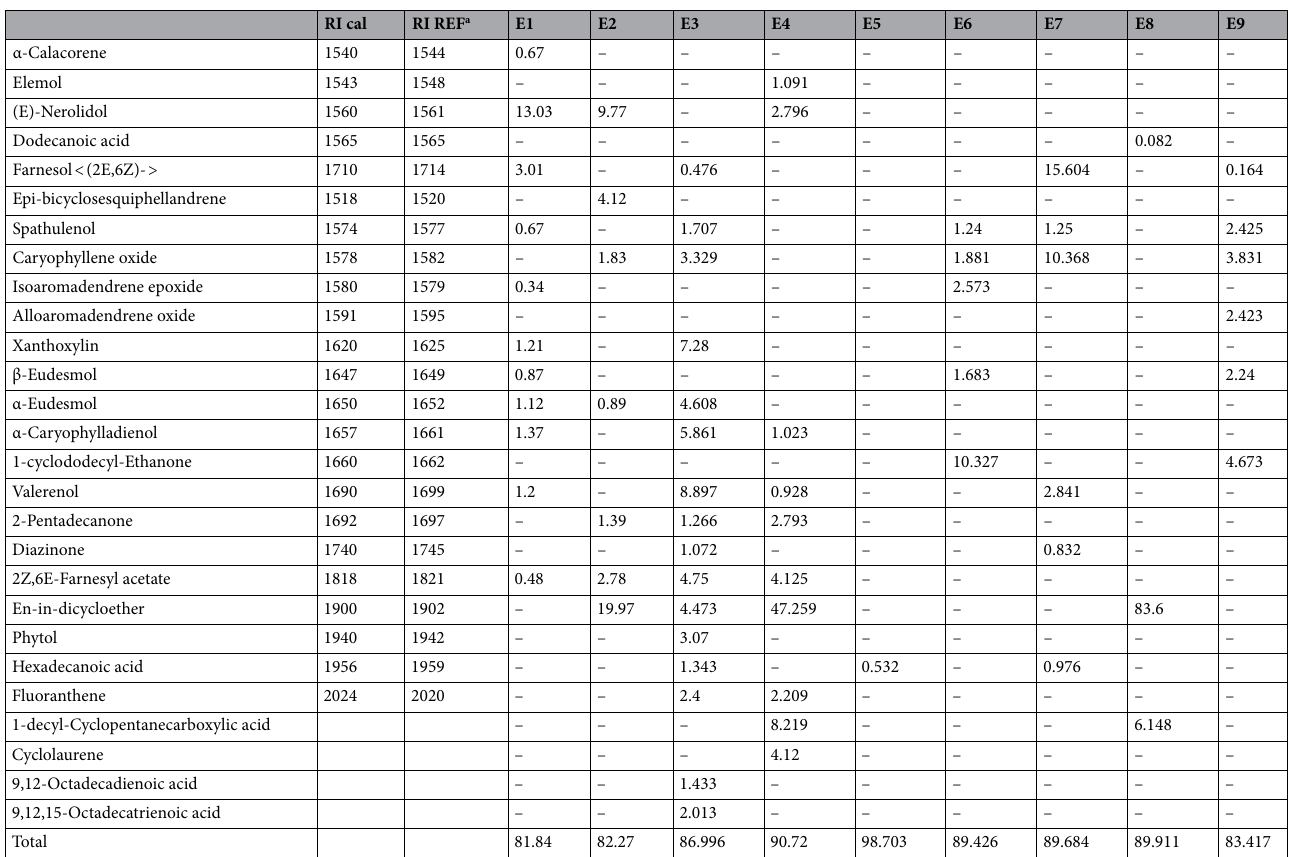
Table 1. Essential oils compounds of Artemisia ecotypes. a Relative retention indices taken from Adams 30 . E1: